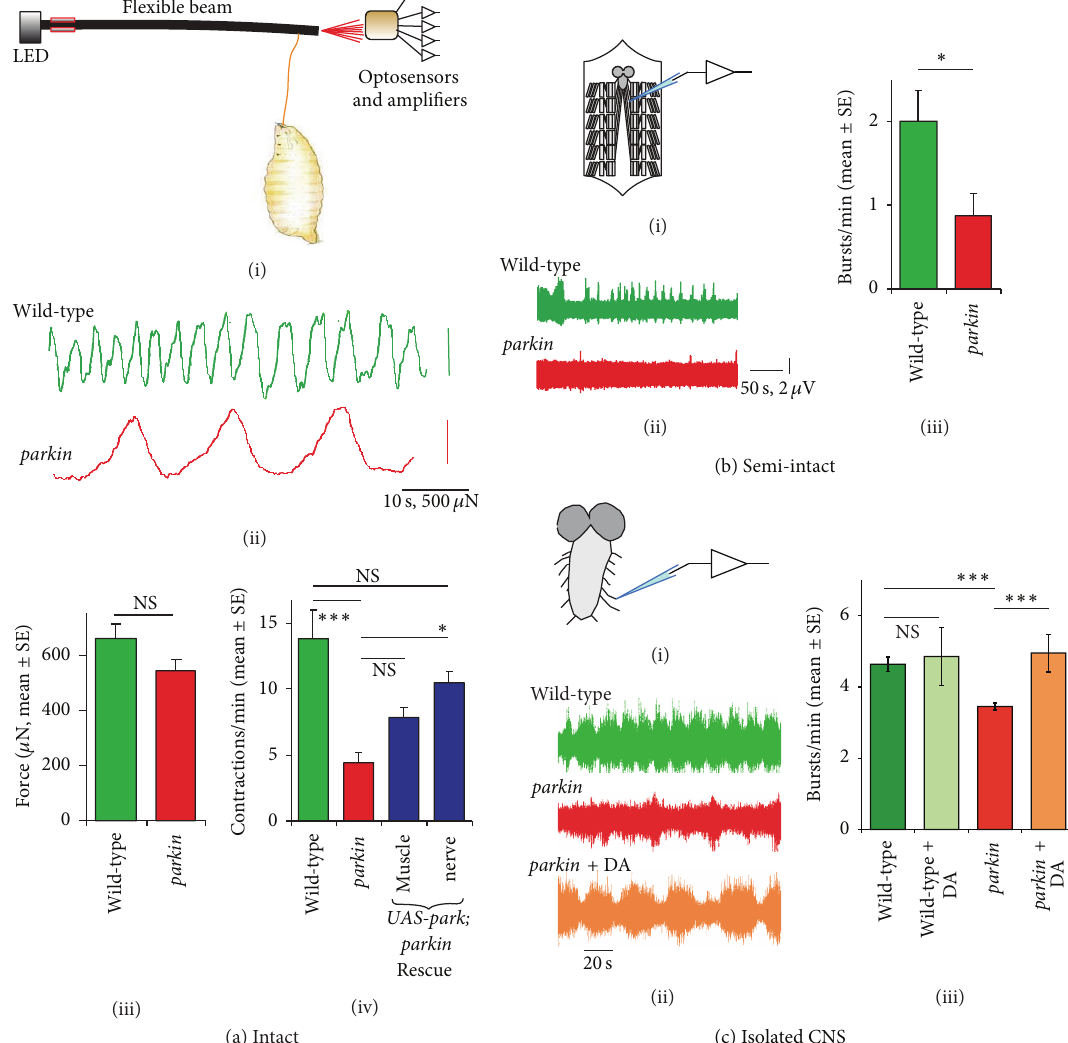
Figure 4: The parkin mutation slows the locomotor CPG, with rescue by neuronal expression of parkin or application of DA to the CNS. (a) Recordings with a larval extensometer (i) show that (ii–iv) the frequency (controlled by the CNS) but not the amplitude (controlled by the muscle performance) is affected by the parkin mutant ( park Z3678 / parkin 25 ). The contraction frequency is rescued by expression of Drosophila wild-type parkin in the nerve ( elav 3e1 GAL4), but not the muscle ( G14 GAL4). (b) In a semi-intact preparation, with en-passant nerve recordings, the frequency of bursting is reduced in the parkin mutant. (c) In the isolated CNS, the fictive locomotion rhythmic bursting pattern is also reduced in the parkin mutant and rescued by application of dopamine (DA, 1mM in HL-3 saline supplemented with 3mM ascorbic acid to reduce oxidation). Data in (a) and (b) from [23], with original recordings in (c).